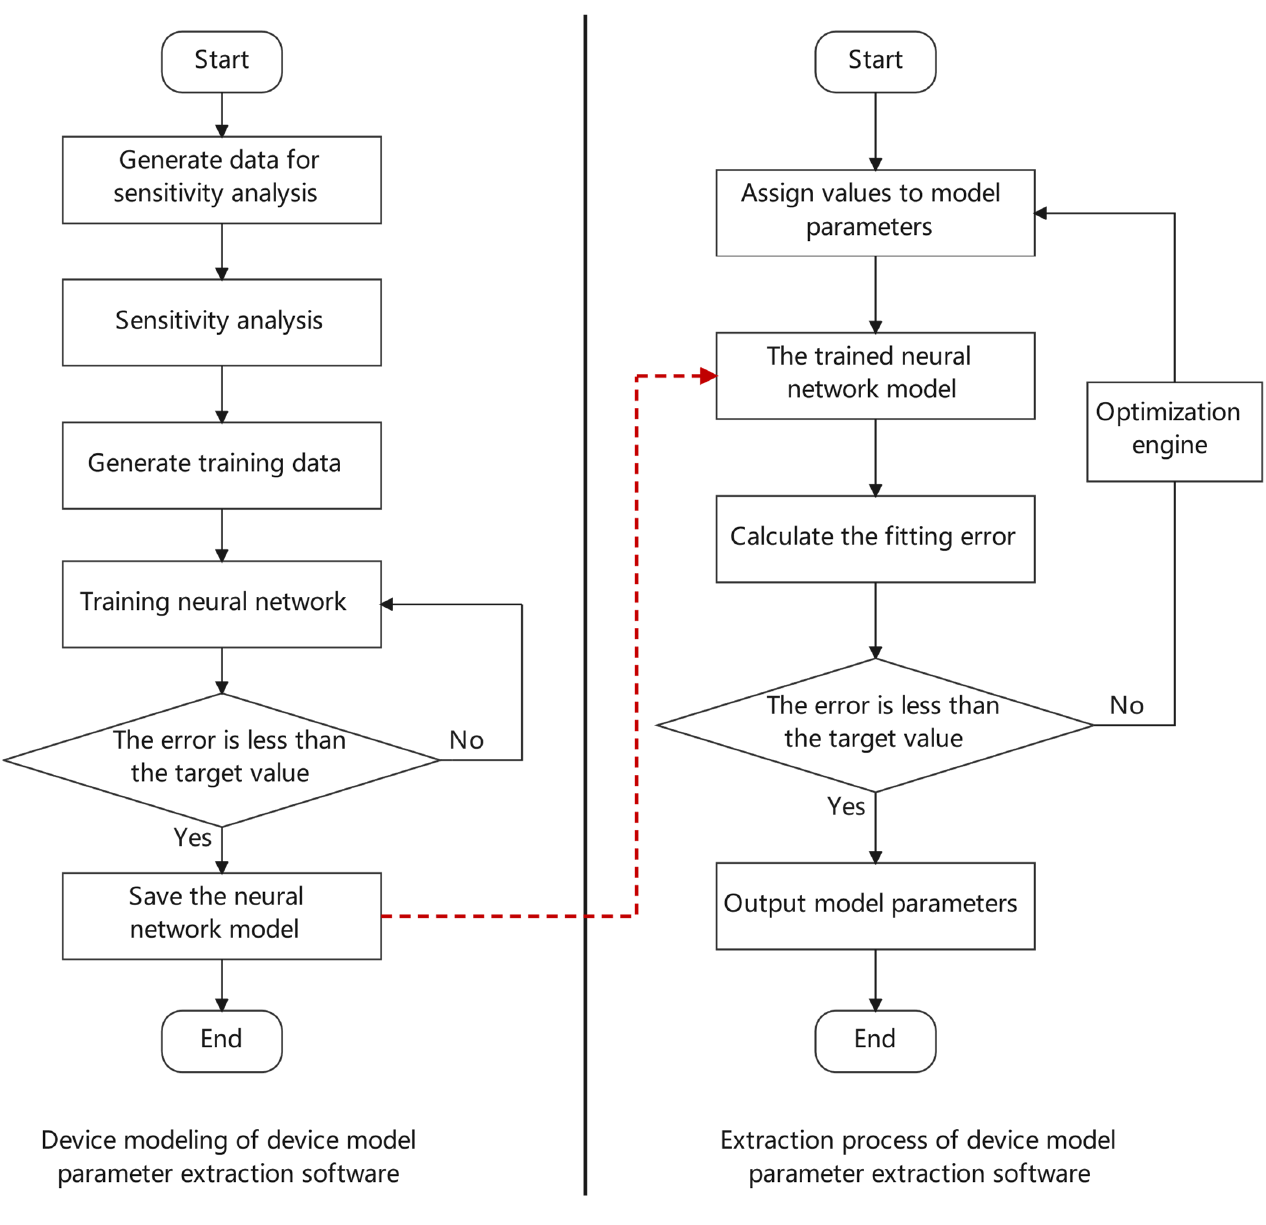
Figure 2. The device modeling flow based on NN and the flow of device model parameter extraction using the NN model.